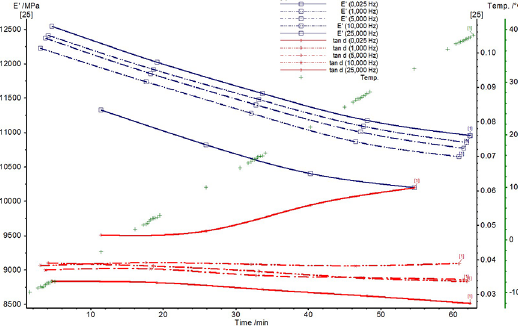
Figure 4. Mechanical spectroscopy of Cedrela sp . from -10°C to 50°C.